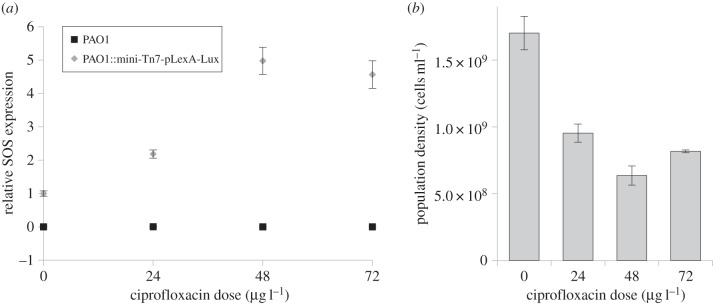
Impacts of ciprofloxacin on bacterial population density and SOS expression. Plotted points in (a) show the mean relative expression (±s.e.m.; n ≥ 3) of a bioluminescent SOS reporter construct across a gradient of ciprofloxacin in a WTpLex : Lux reporter strain (grey diamond) and a WT control lacking the reporter construct (black square). (b) The mean (±s.e.m.; n ≥ 3) density of viable cells in cultures of the WT strain that were grown overnight across a gradient of ciprofloxacin.